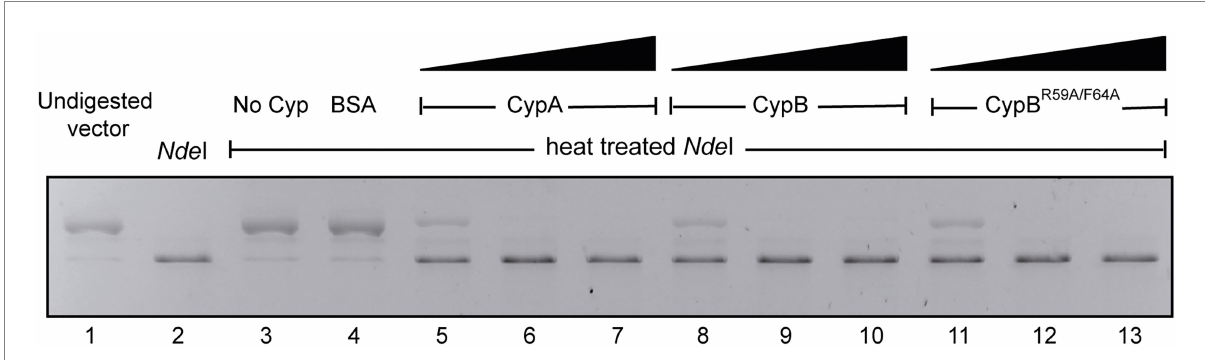
FIGURE 5 CypA and CypB of B. abortus prevent thermal inactivation of Nde I activity. Enzymatic activity of thermal-denatured Nde 1 (53.8 ° C for 20 min) in the absence or presence of CypA, CypB, CypB R59A/F64A , or BSA as a control protein. Lane 1, uncut pET28 plasmid; lane 2, pET28 plasmid incubated with native Nde I; Lane 3, pET28 plasmid incubated with heat-inactivated Nde I; Lane 4, pET28 plasmid incubated with heat-inactivated Nde I in the presence of BSA (5 μ g); Lane 5, 6, and 7, pET28 plasmid incubated with heat-inactivated Nde I in the presence of increasing concentrations of CypA protein (1, 2.5, and 5 μ g); Lane 8, 9, and 10, pET28 plasmid incubated with heat-inactivated Nde I in the presence of increasing concentrations of CypB protein (1, 2.5, and 5 μ g); Lane 11, 12, and 13, pET28 plasmid incubated with heat-inactivated Nde I in the presence of increasing concentrations of CypB R59A/F64A protein (1, 2.5, and 5 μ g). The gel is representative of three independent